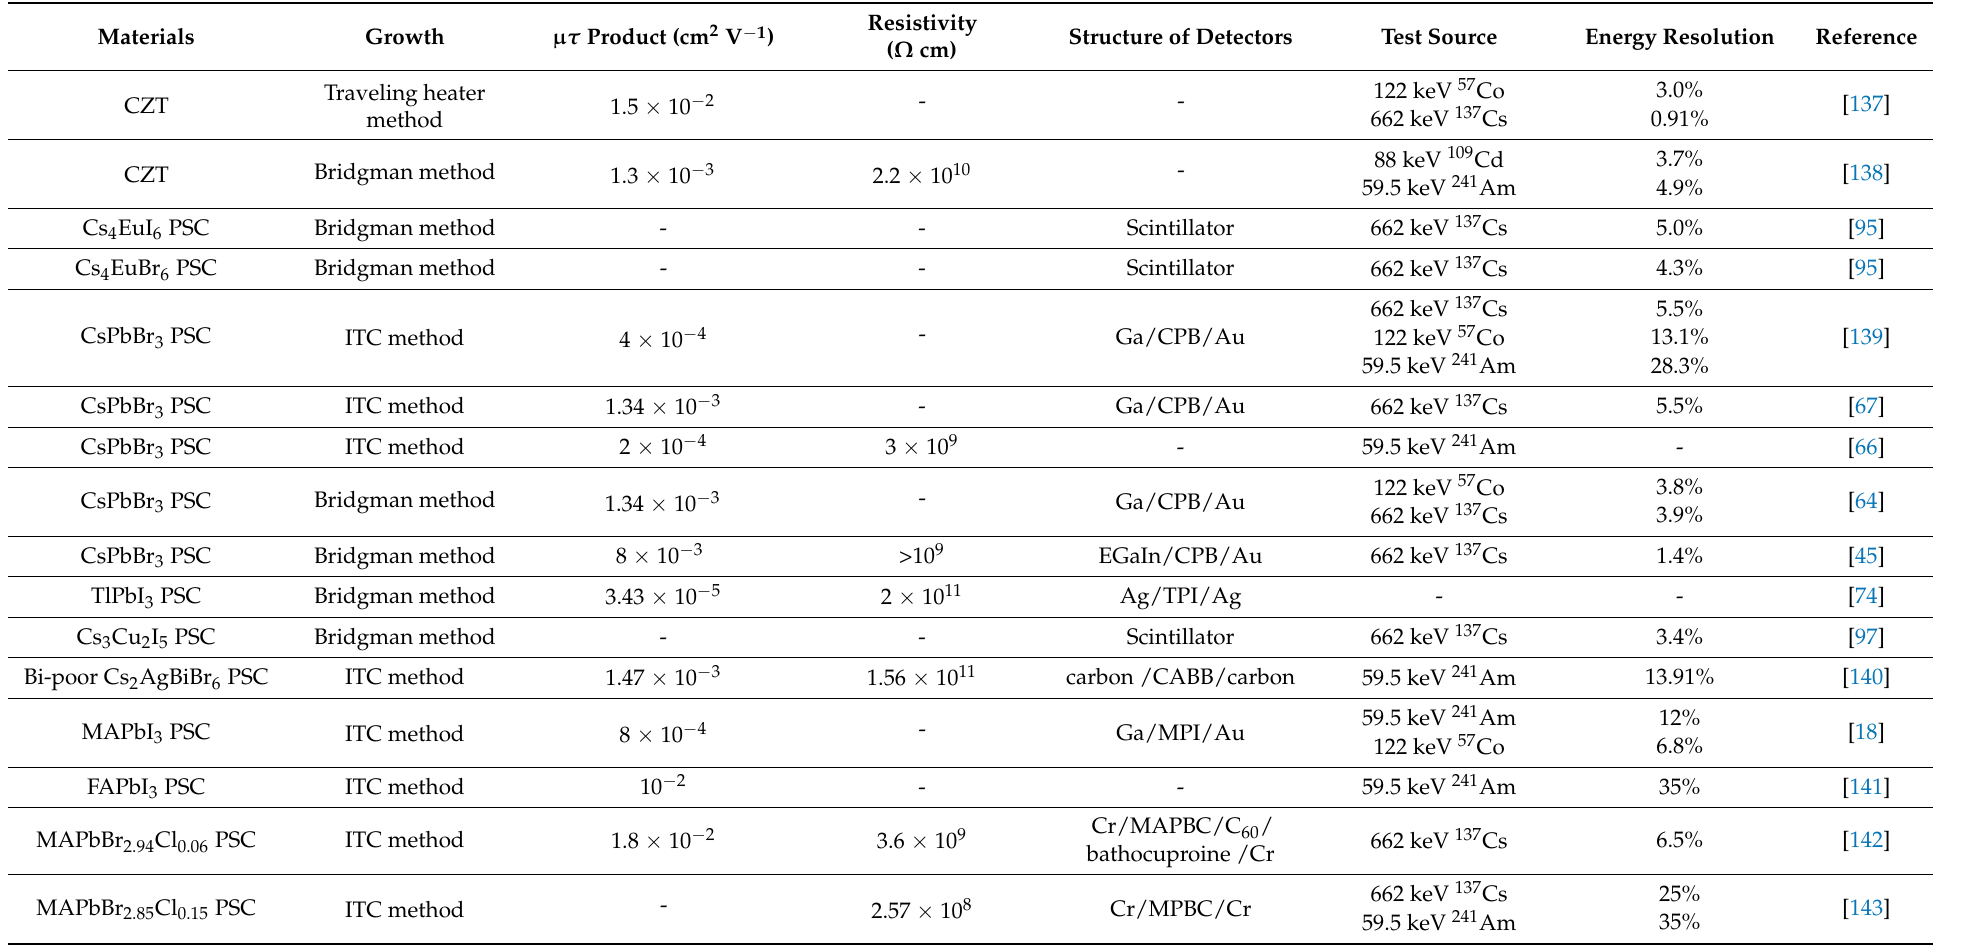
Table 2. Detailed information about the applications of gamma-ray